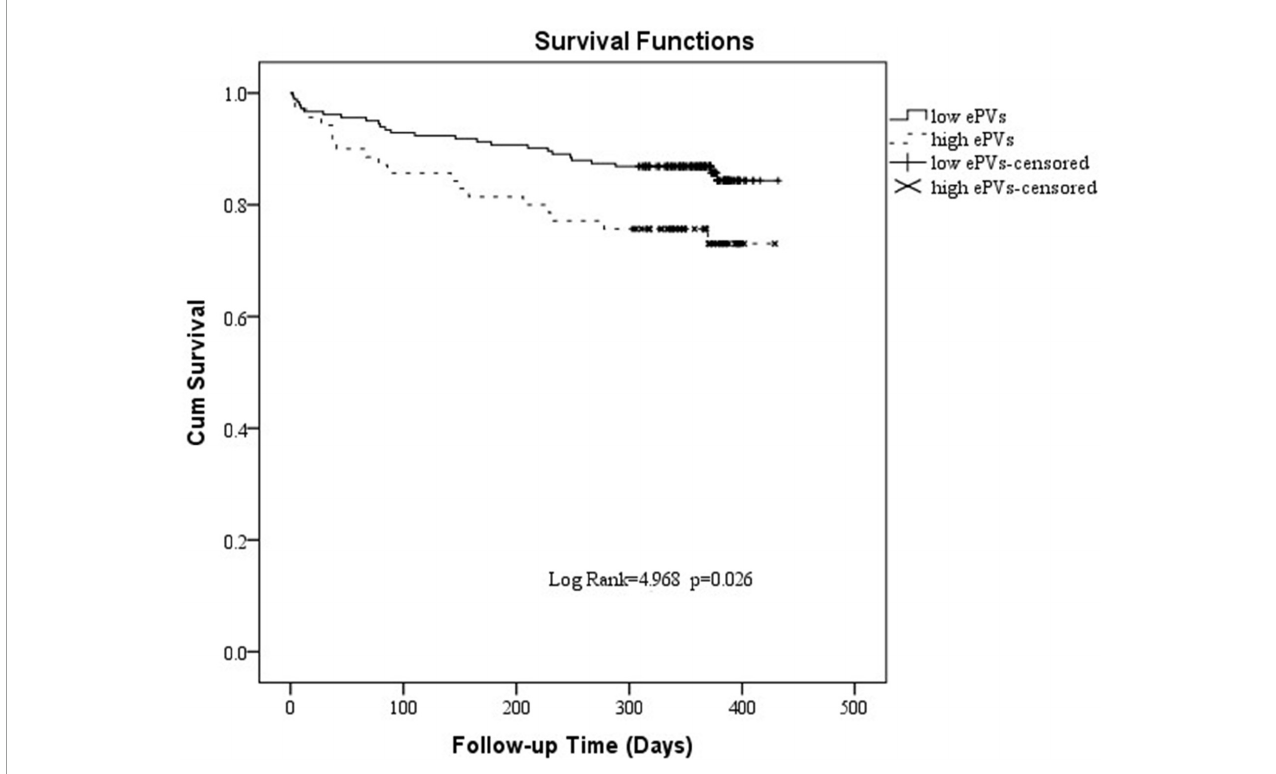
FIGURE2 Kaplan-Meier survival curve of 1 year cardiogenic death in patients with high estimated plasma volume status (ePVs) and low ePVs groups.